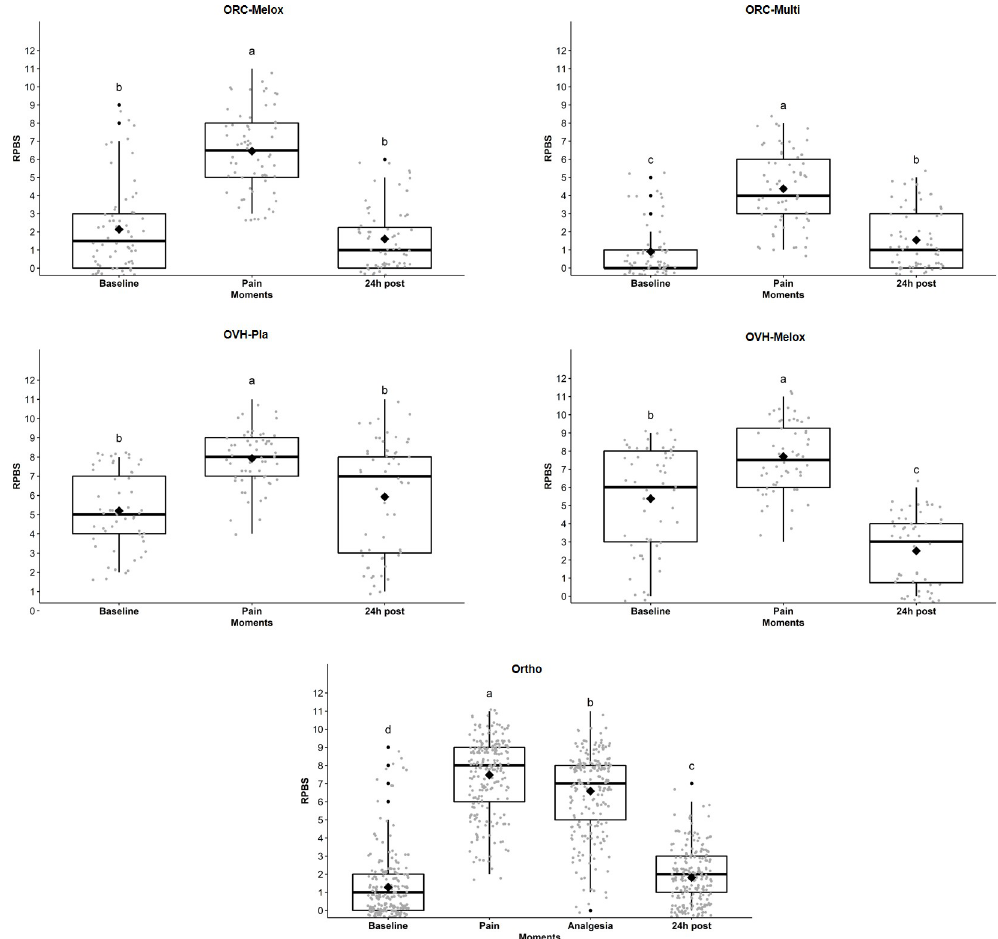
Fig 3. Box-plots of the scores (median/amplitude) of the RPBS (rabbit pain behaviour scale), comparing the perioperative time points for each group. The top and bottom box lines represent the interquartile range (25 to 75%), the line within the box represents the median, the extremes of the whiskers represent the minimum and maximum values, black lozenges ( ♦ ) represent the mean and black circles (•) represent outliers. RPBS: Rabbit pain behaviour scale. Groups: Ortho— 28 rabbits submitted to radio ostectomy; OVH-Pla—7 rabbits submitted to OVH under placebo administration; OVH-Melox– 7 rabbits submitted to OVH under meloxicam administration; ORC-Melox—8 rabbits submitted to orchiectomy under meloxicam administration; ORC-Multi– 8 rabbits submitted to orchiectomy under the administration of a multimodal analgesic protocol. Different letters express significant differences between time points where a > b > c > d, according to the mixed linear